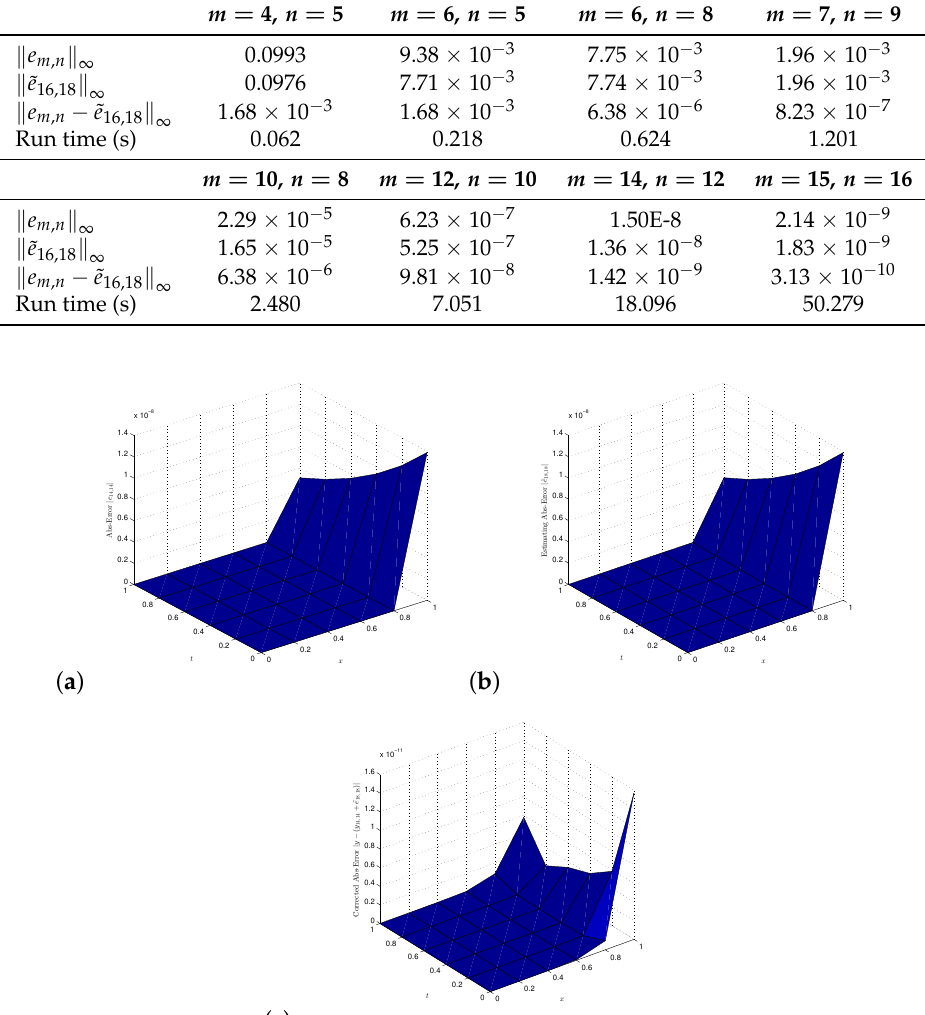
Table 5. The norms of absolute errors, the estimation of the errors by using the residual correction procedure, and the errors obtained by the corrected approximate solutions of Example 2 for s = 16 and p = 18.